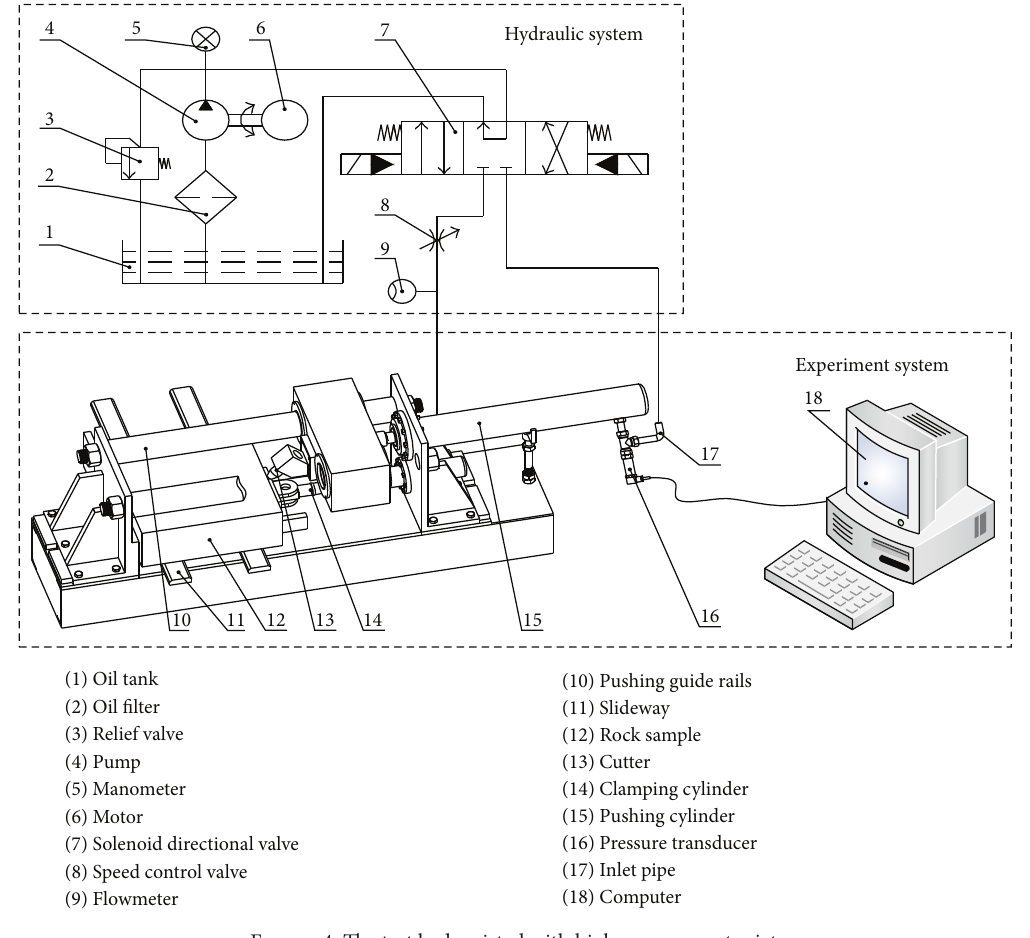
Figure 4: The test bed assisted with high pressure water jet.